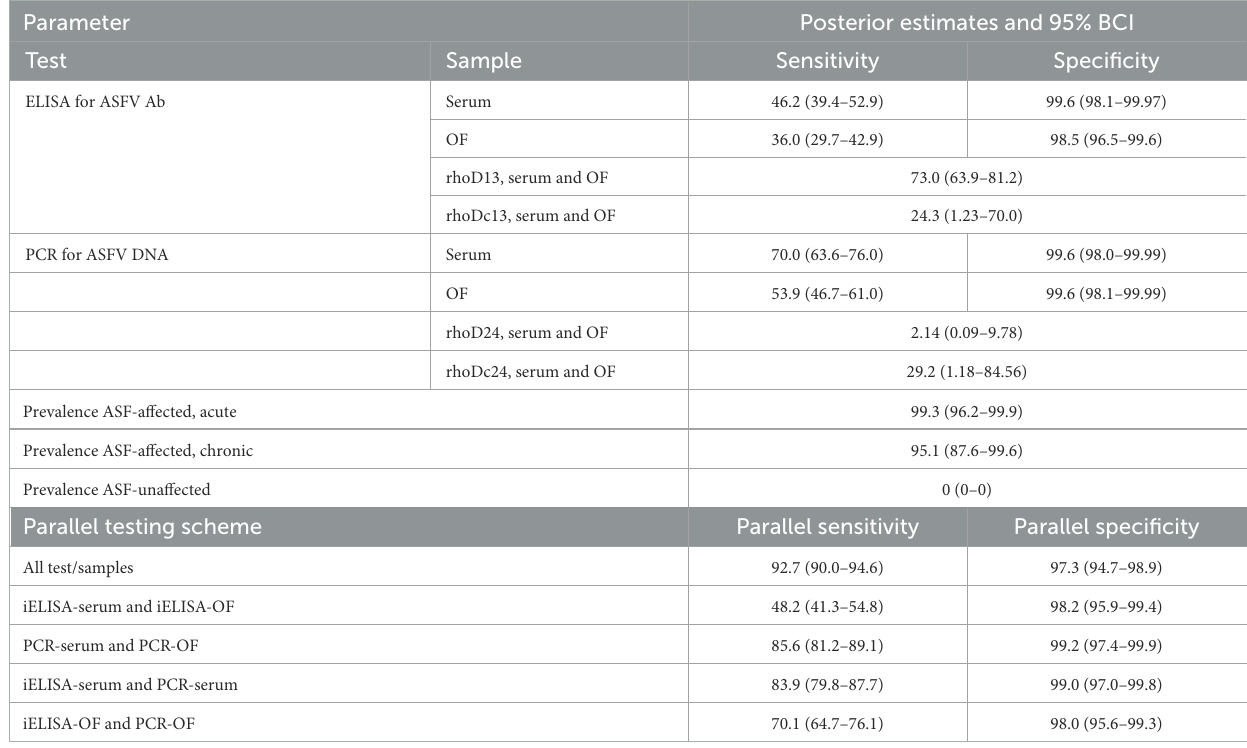
TABLE 5 BLCA posterior estimates of iELISA and qPCR diagnostic sensitivity and specificity (%) in serum and oral fluid samples with 95% Bayesian credibility intervals (BCI).